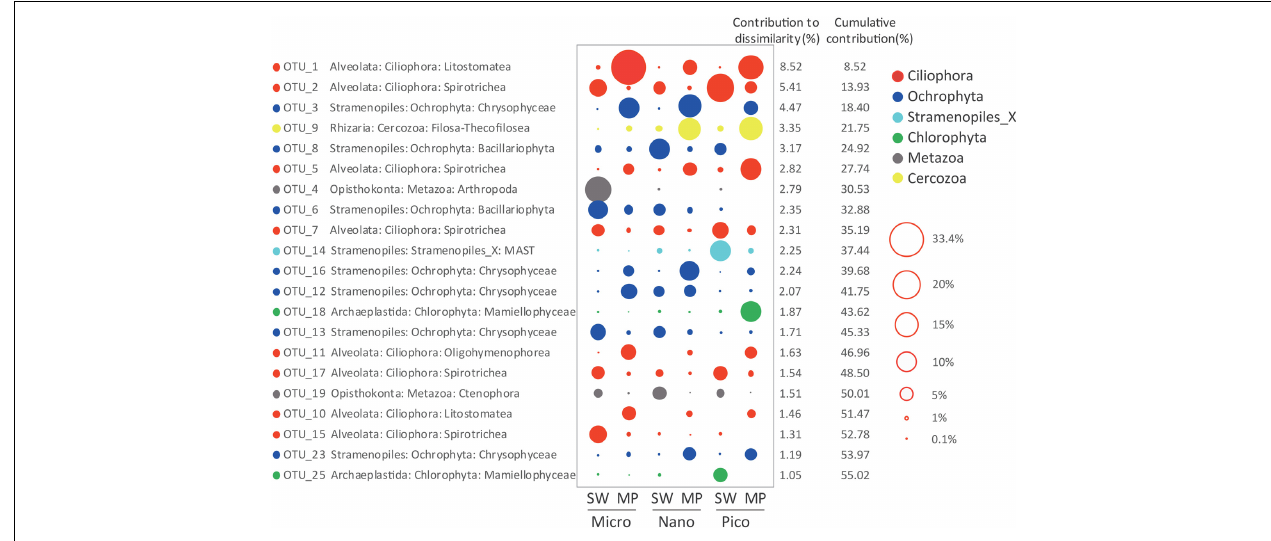
FIGURE 7 | Taxonomic identities of the 21 ZOTUs that contributed most to community dissimilarities between sea water (SW) and melt ponds (MPs) with their relative contributions to community dissimilarities. The diameters of the circles are proportional to the abundances of the ZOTUs, with the size of the circle indicating the average abundance of each ZOTU at a given size of SW and MP